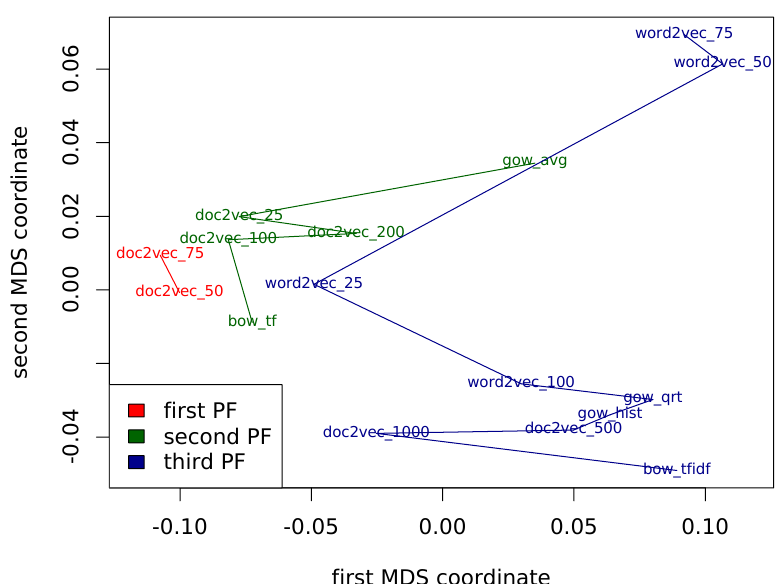
Figure 1. The four-dimensional space of the per-class area under the receiver-operating curve (AUROC) performance of the 16 variants of the document representation models measured for each of the four class labels of the Brown4 data set (projected into two dimensions). The two-dimensional projection of the four-dimensional space was obtained using multidimensional scaling